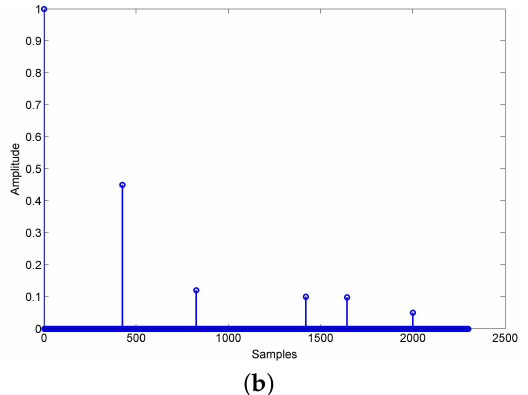
Figure 5. Channel model in simulation ( a ) UWA SI channel; ( b ) intended channel.